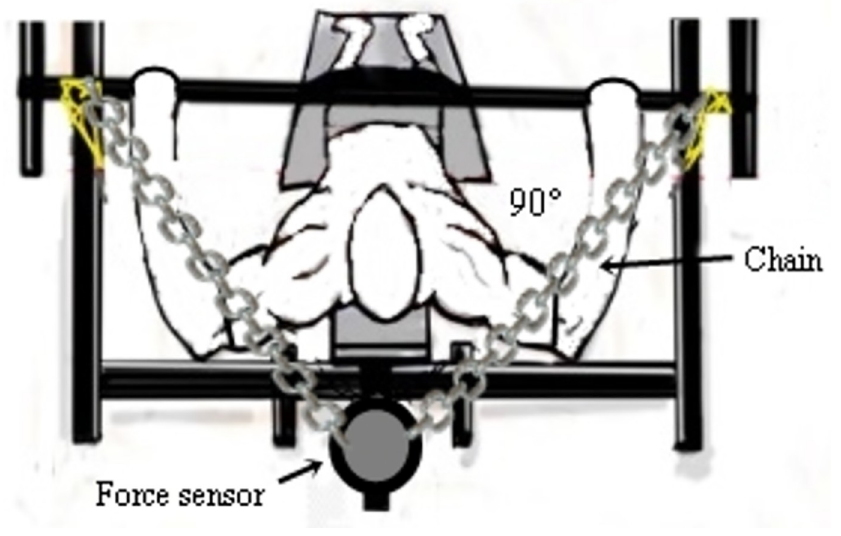
Fig 2. Placement of the force